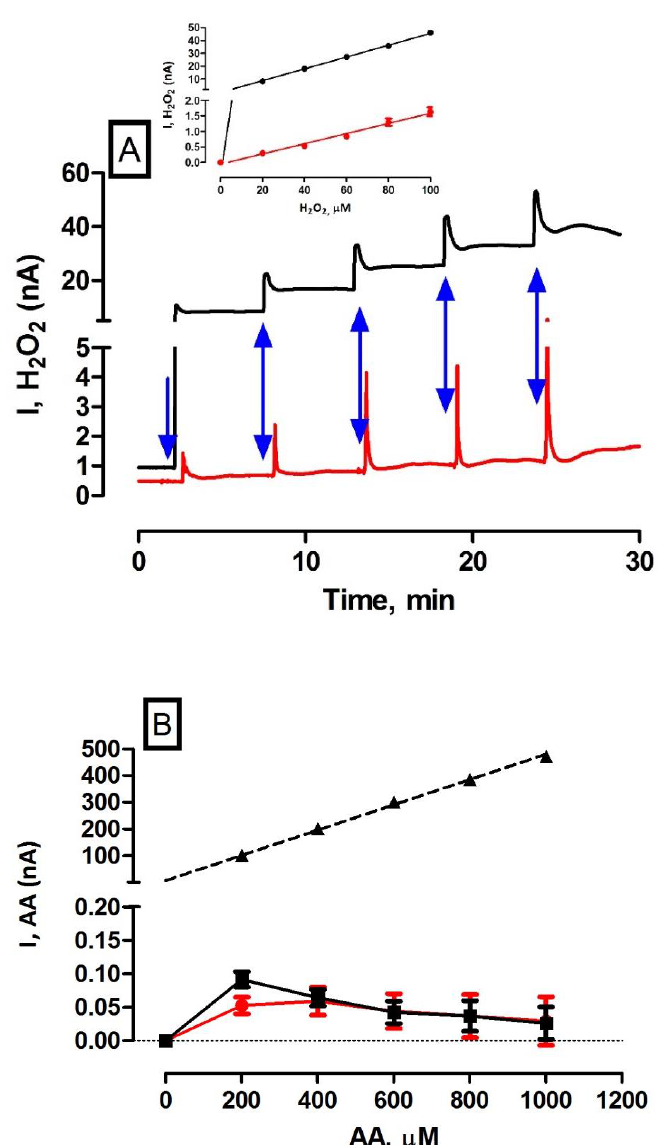
Figure 1. ( A ) Typical in vitro data obtained for a 0 to 100 µ M H 2 O 2 calibration using H 2 O 2 blank electrode (black trace) and catalase electrode (red trace). Blue arrows indicate addition of 20 µ M H 2 O 2 aliquots. Inset: Current concentration profiles for H 2 O 2 calibration on H 2 O 2 blank electrode ( n = 39, r 2 = 0.99, black trace) and H 2 O 2 catalase electrode ( n = 39, r 2 = 0.99, red trace). ( B ) Current concentration profiles for AA calibration (0–1000 µ M) on H 2 O 2 blank electrode ( n =12, black trace), H 2 O 2 catalase electrode ( n = 12, red trace) and unmodified bare platinum (Pt) electrode as comparison ( n = 24, r 2 = 0.99, dashed trace). All concentration profile data are presented as mean ± SEM.